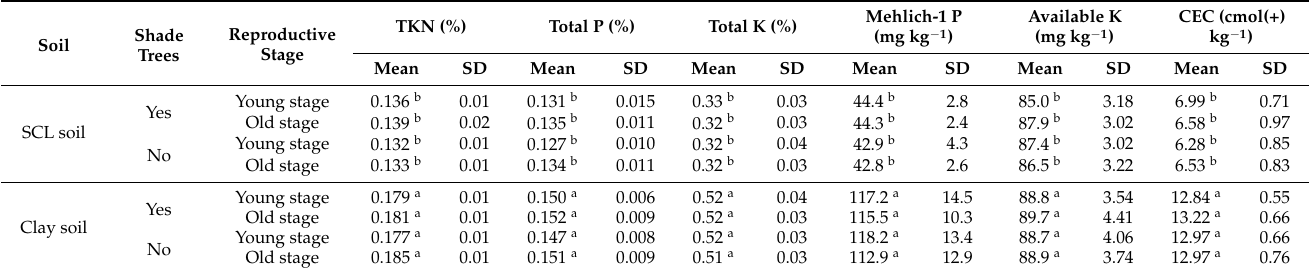
Table 2. The concentration of TKN (Total Kjeldahl nitrogen), total P, total K, available P and K, and CEC of the examined soils. Within the mean column, data attached with the same letter were not significantly different from each other. Details of the main and interaction effects of three experimental factors were shown in Supplementary Table S2. SCL = sandy clay loam; SD = standard deviation.